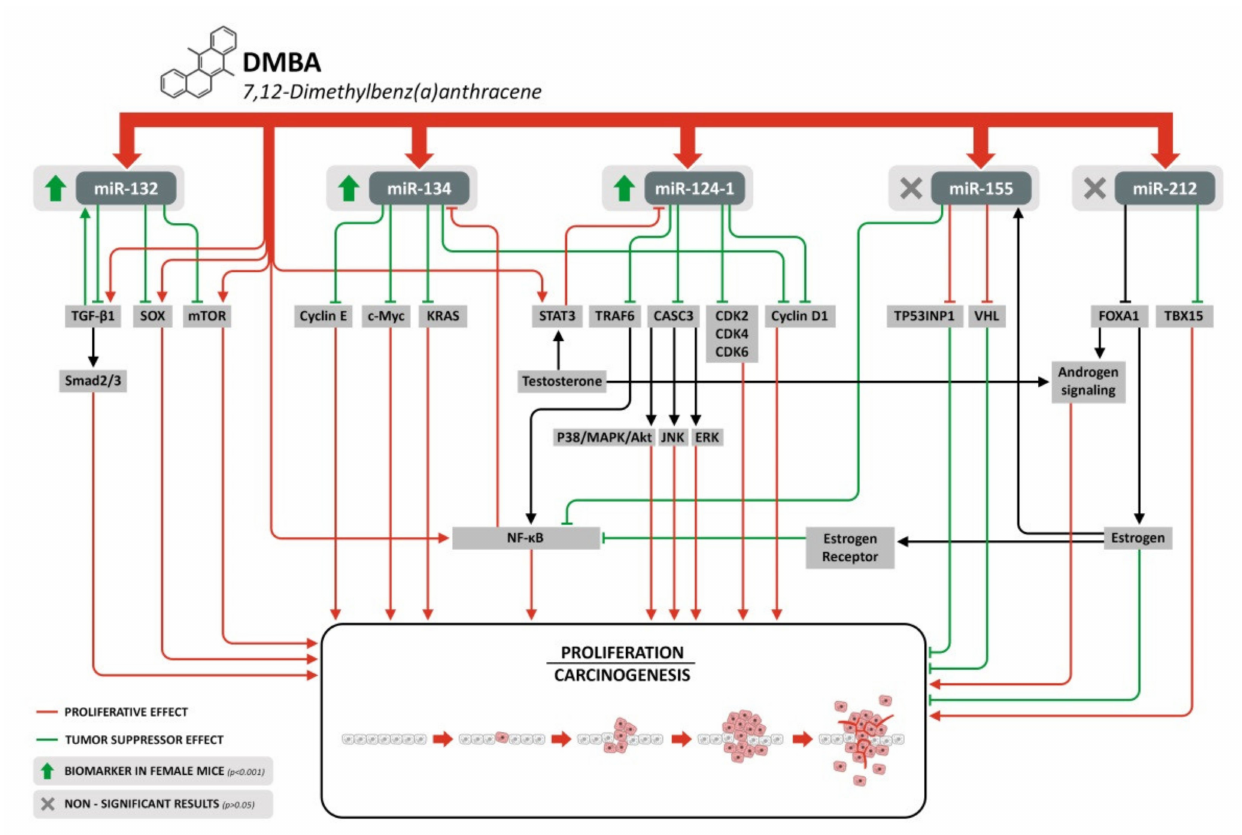
Figure 5. Summary of the affected relevant signaling pathways and the role of the expression changes of the investigated miRNAs (miR-134, miR-132, miR-124-1, miR-212, and miR-155) 24 h after DMBA